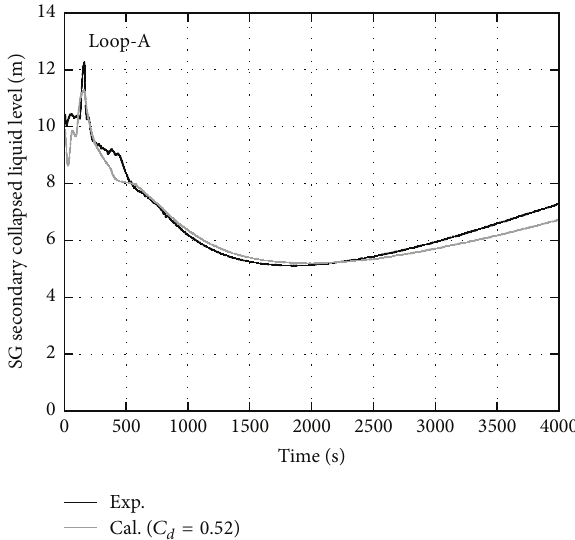
Exp. Figure 10: LSTF and RELAP5 results for SG secondary-side col- lapsed liquid level in loop-A in case of release of dissolved